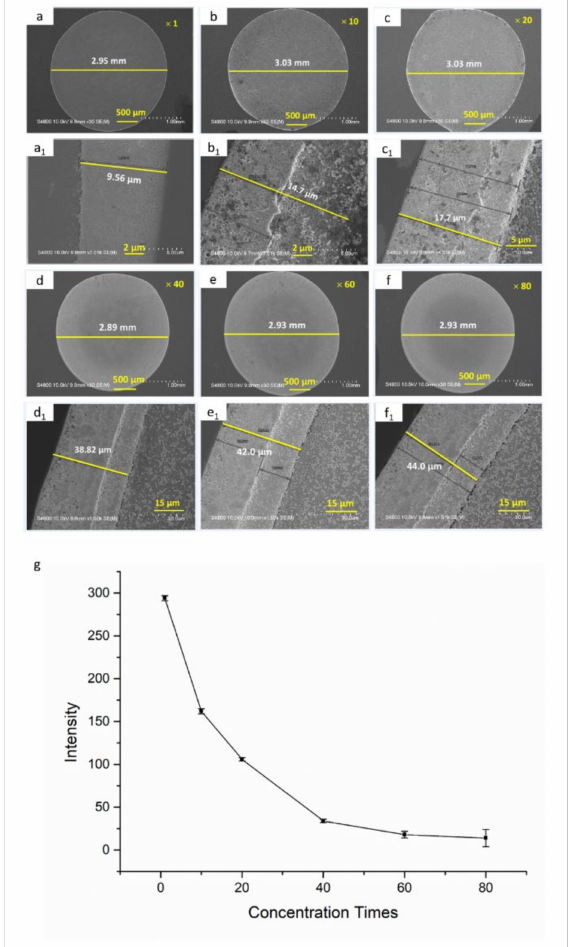
Figure 3. ( a – f 1 ) SEM images of the coffee ring formed from water-washed Au NP colloids with different concentration times. ( g ) The tendency of Raman intensity of 10 − 6 M R6G in the coffee ring with different concentration times of water-washed Au NP colloids based on the peak of 1364 cm − 1 . The Raman data were collected from the DXR Smart Raman spectrometer (Thermo Fisher Scientific, Waltham, MS, USA): excitation wavelength, 780 nm; maximum excitation power, 80 mw; integration time, 15